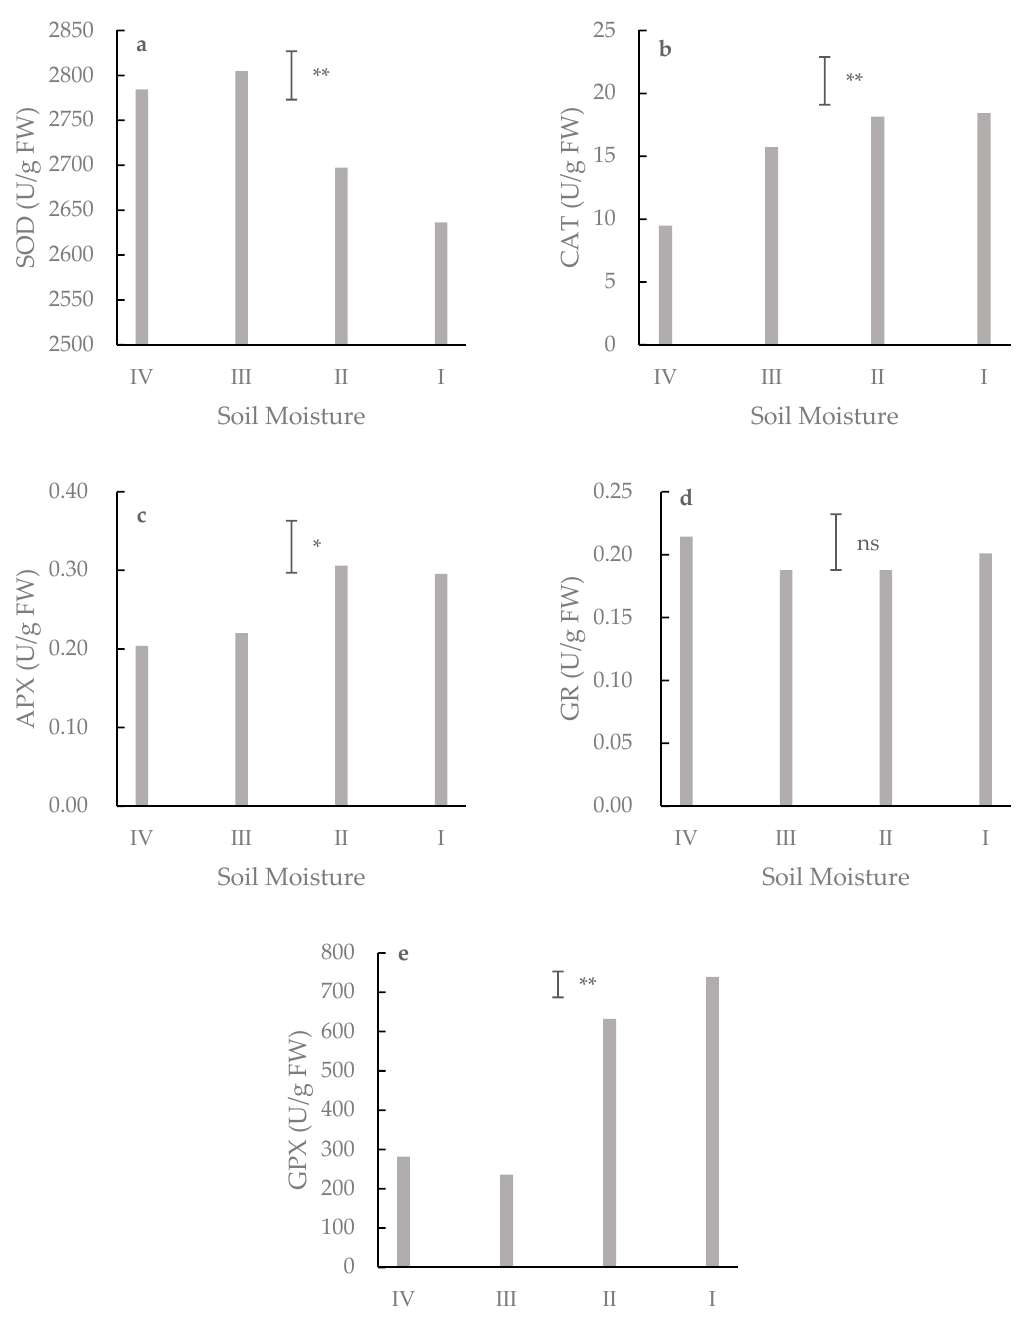
Figure 10. Antioxidant enzyme activity of ( a ) SOD, ( b ) CAT, ( c ) APX, ( d ) GR, and ( e ) GPX in alfalfa root under various soil moisture treatments (See Figure 2 for soil moisture abbreviations). * p < 0.05; ** p < 0.01; ns-no significant.